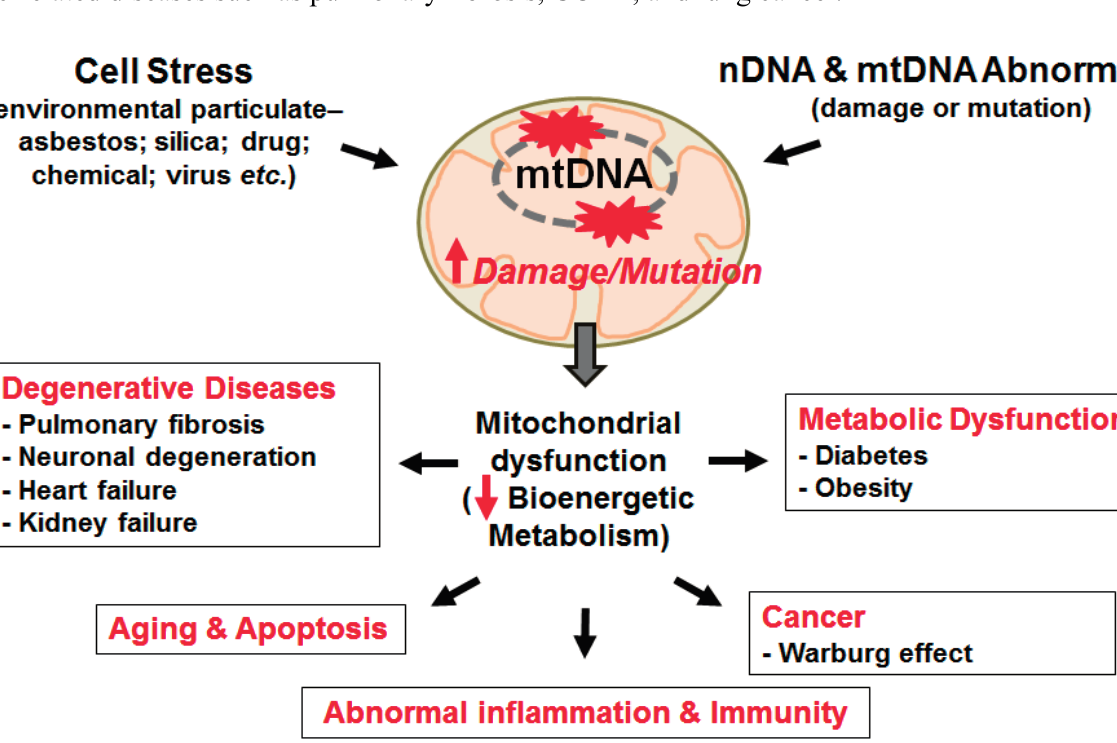
Figure 1. Hypothetical model whereby mtDNA damage induces diverse degenerative diseases. MtDNA damage and mutation can be induced by cell stress from environmental particulates and/or DNA abnormality. MtDNA damage/mutation cause mitochondrial dysfunction reducing bioenergeneric metabolism that can promote degenerative diseases, metabolic dysfunction, aging, apoptosis and cancer. Red-up arrow, increase; red-down arrow,